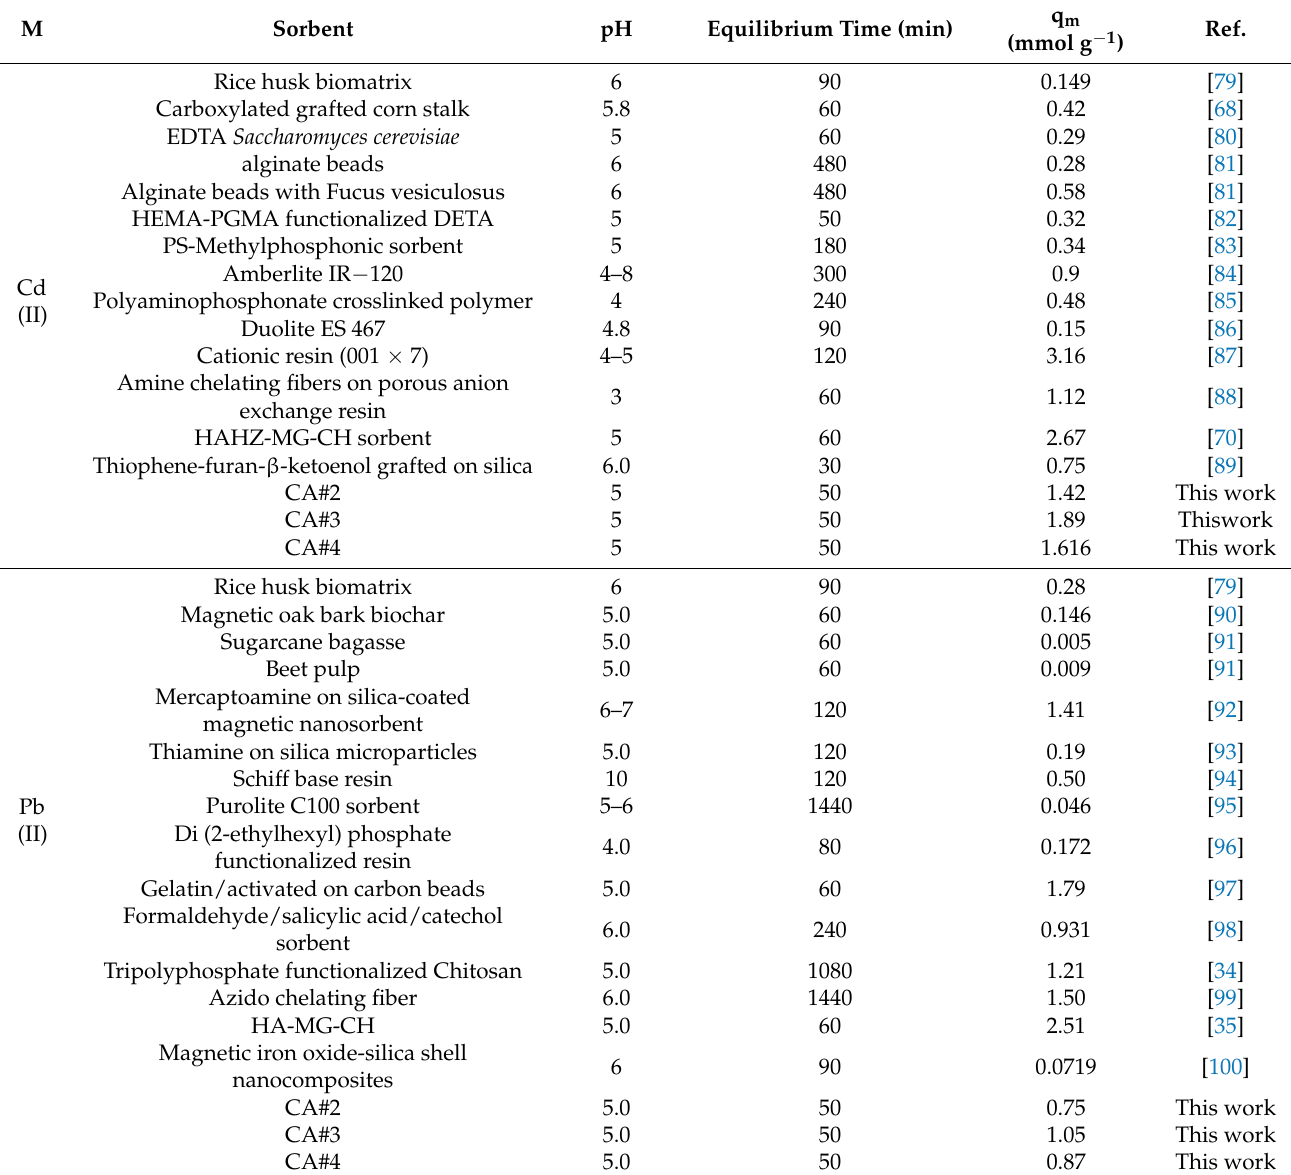
Table 3. Comparison of the sorption properties (qm, mmol g − 1 ) for Cd(II) and Pb(II) with other alternative